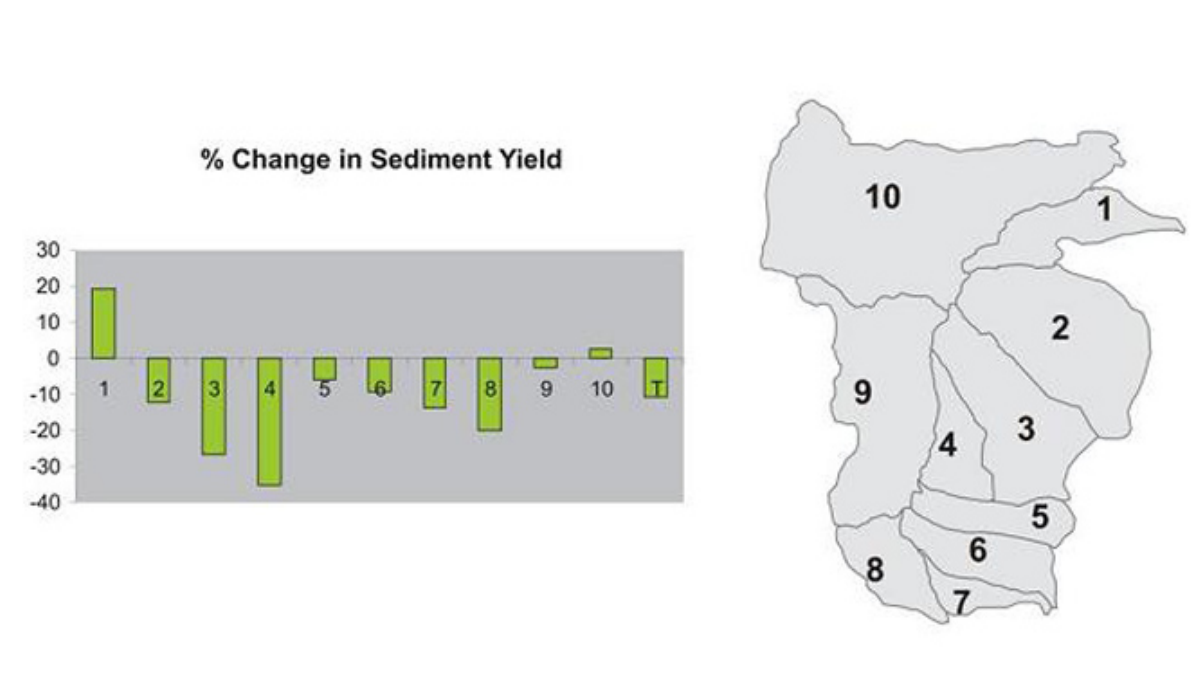
Fig. 6. Relative change (%) in modeled sediment between 1972 and 2006 in the different watersheds of the study area. T indicates the total study